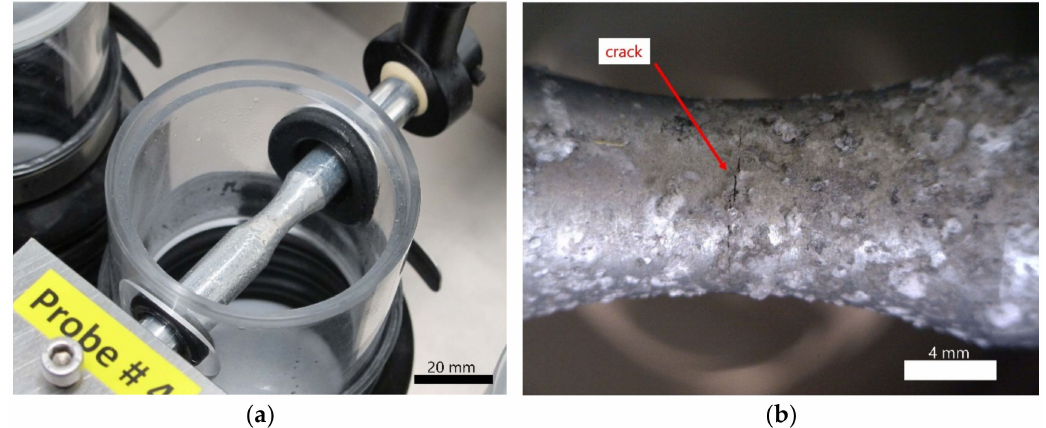
Figure 8. Corrosion fatigue tests: ( a ) specimen in the environmental chamber and ( b ) specimen surface after testing.